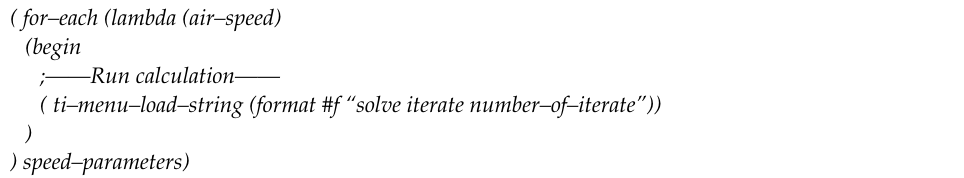
Algorithm 1. Exemplary code snippet for calling ANSYS Fluent with dynamic parameter passing using TUI and Scheme